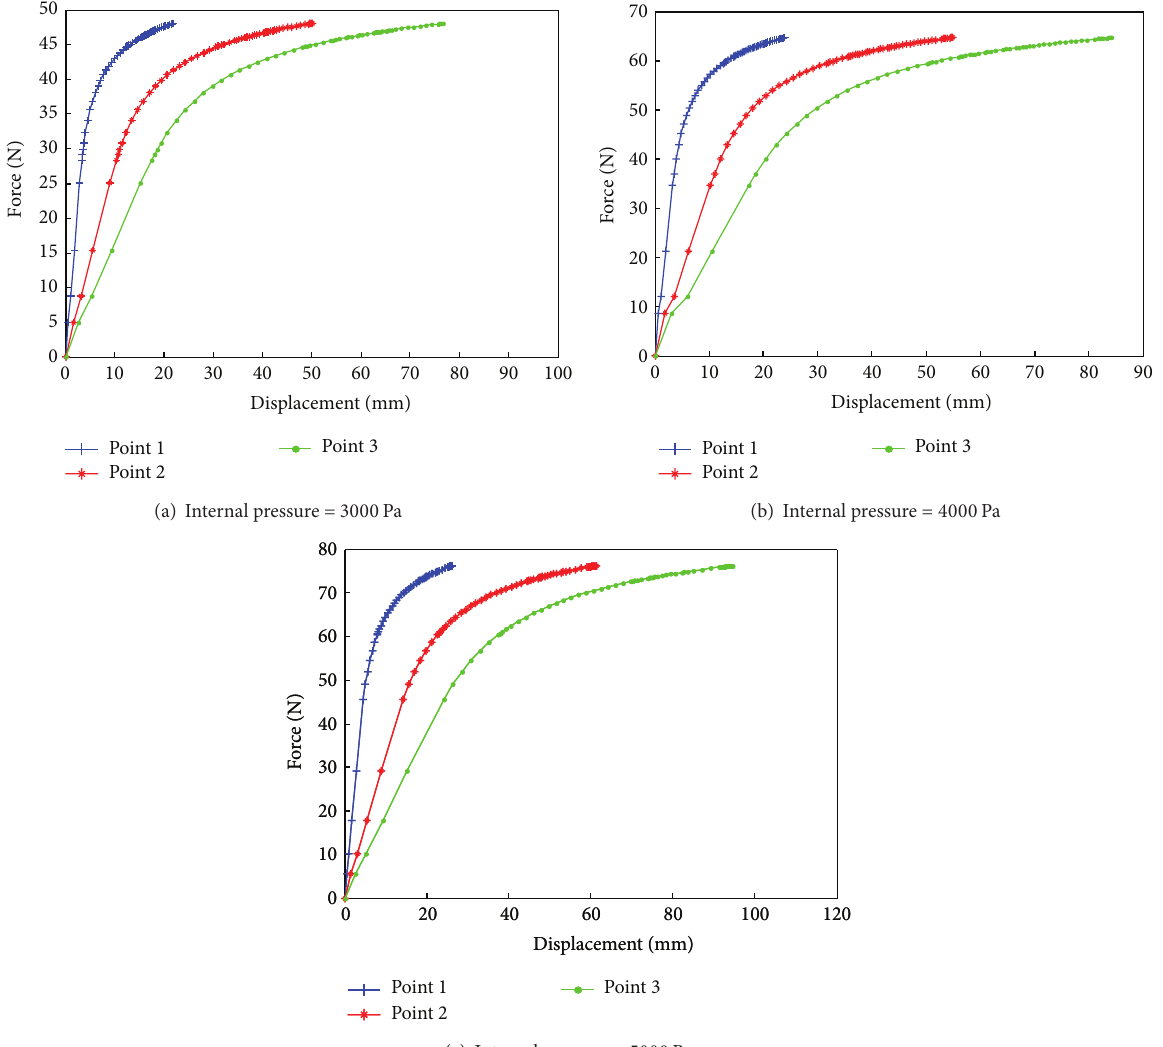
Figure 7: Load-deflection behavior of the ETFE inflatable tube using tension field theory.